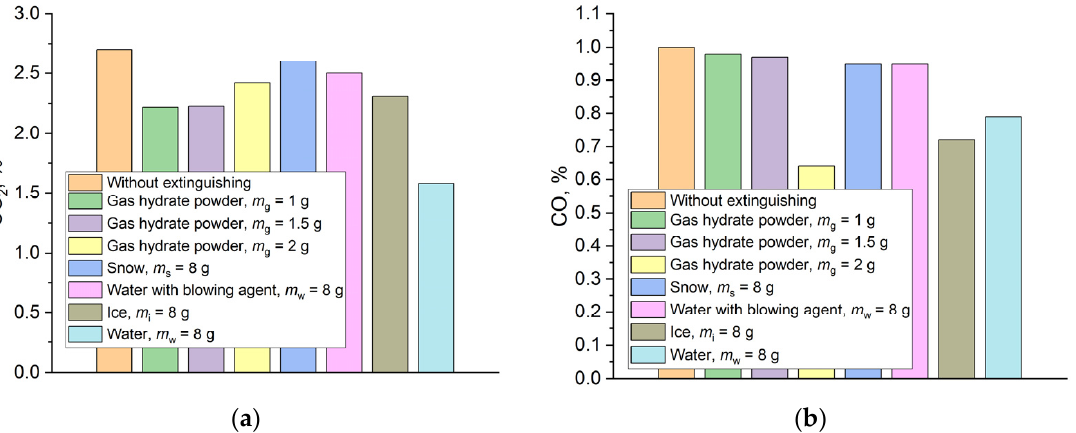
Figure 9. Concentrations of CO 2 ( a ) and CO ( b ) from the suppression of a gasoline fire ( V 0 ≈ 3 mL) by different extinguishing agents. Figure 10. Concentrations of CO 2 ( a ) and CO ( b ) from the suppression of flammable liquids (diesel fuel, kerosene, oil, and alcohol) by CO 2 hydrate.